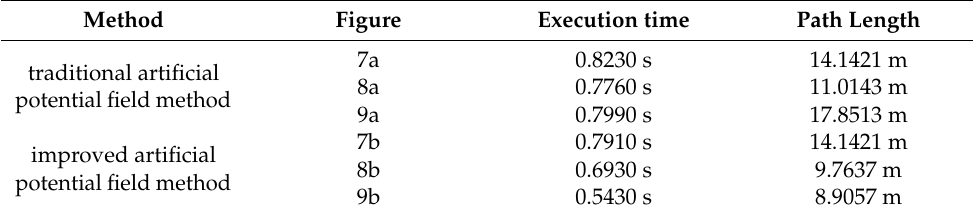
Table 3. The comparison results between the improved and traditional algorithm. Method Figure Execution time